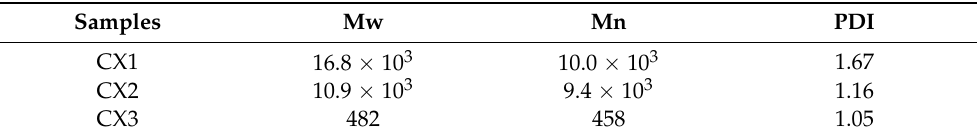
Table 2. Weight-average (Mw) and number-average (Mn) molecular weight and polydispersity (PDI, Mw/Mn) in the aqueous phase after